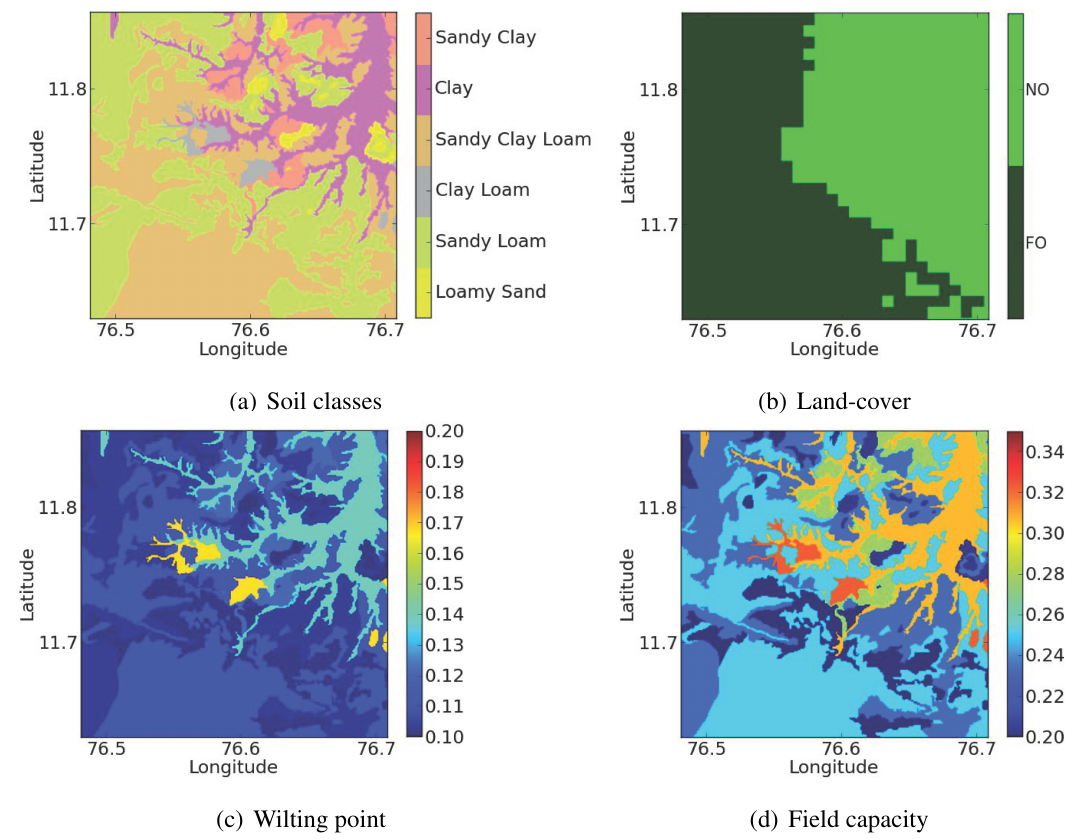
Figure 2. Soil and land-cover map for the study area. In the land-cover, NO is the nominal surface (bare soil and low vegetation) and FO is the forest. ( a ) Soil classes, ( b ) Land-cover, ( c ) Wilting point, ( d ) Field